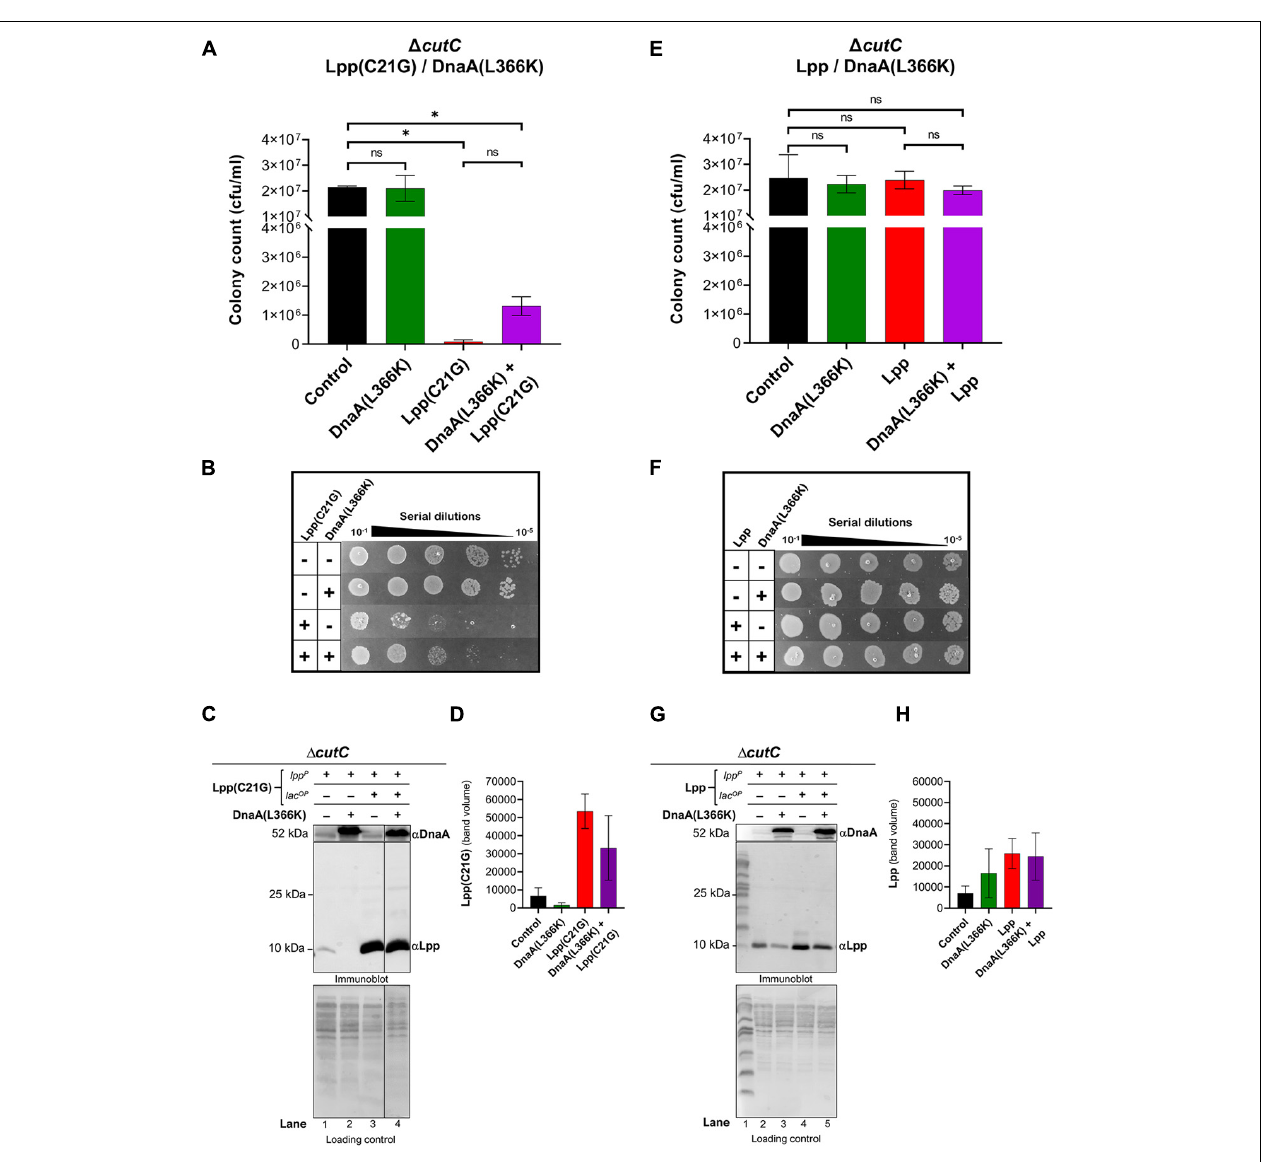
FIGURE 3 | Overexpression DnaA(L366K) res to res limited growth but fails to reduce levels of Lpp(C2 1G ) when the promoter for MicL-S small RNA is absent. (A) Viability of cutC-null cells expressing DnaA(L366K) and Lpp(C21G). No inducer control (black), in the presence of 0.2% Arabinose (green) for DnaA(L366K), 50 µ M IPTG (red) for Lpp(C21G), and 50 µ M IPTG + 0.2% Arabinose (purple) for both Lpp(C21G) and DnaA(L366K) expression in M9+CAA+Glu media. (B) Serial dilutions of cutC-null cells, capable of expressing Lpp(C21G) and DnaA(L366K), on agar plates. (C,D) Immunoblotting for the detection of DnaA(L366K) and Lpp(C21G) and quantitative analysis of Lpp(C21G) levels. (E) Viability of cutC-null cells expressing DnaA(L366K) and Lpp. No inducer control (black), in the presence of 0.2% Arabinose (green) for DnaA(L366K), 50 µ M IPTG (red) for Lpp, and 50 µ M IPTG + 0.2% Arabinose (purple) for both Lpp and DnaA(L366K) expression in M9+CAA+Glu media. (F) Serial dilutions of cutC-null cells, capable of expressing plasmid-derived Lpp and DnaA(L366K), on agar plates. (G,H) Immunoblotting for the detection of DnaA(L366K) and Lpp and quantitative analysis of Lpp levels. Lpp(C21G) and Lpp are expressed via Lpp (lpp P ) and Lac (lacUV5 OP ) promoters. All loading controls are ponceau-S staining for total protein normalization presented in grayscale. Viability is expressed in cfu/ml and presented on a linear scale. Data are means ± SEM of at least three independent experiments. ∗ p < 0.05, ns p > 0.05 in one-way ANOVA with Dunnett’s multiple comparison test.